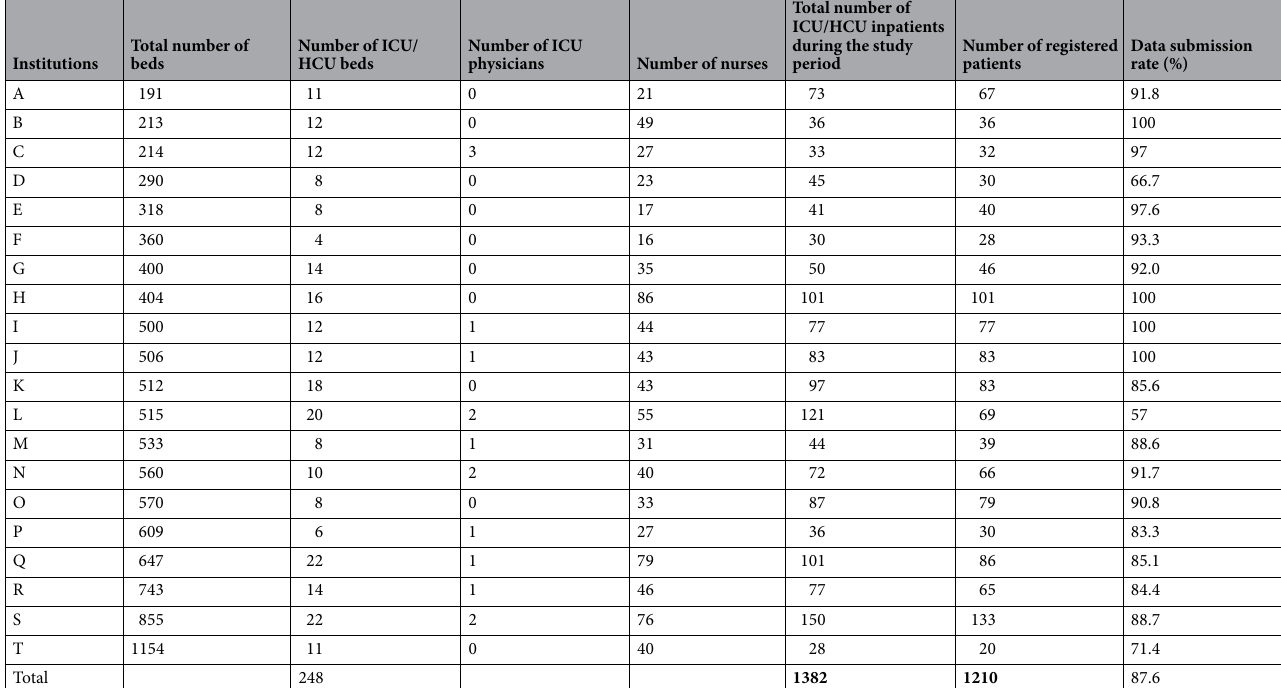
Table 2. Basic characteristics of each institution, number of registered patients, and submission rate. HCU high care unit, ICU intensive care unit, A, B, C…, S, T represent participating institutional (anonymous). We included 1382 patients who were newly admitted to and discharged from the ICU/HCU, but excluded 172 patients because of missing data; therefore, we collected and analyzed data for 1210 patients. Significant values are in